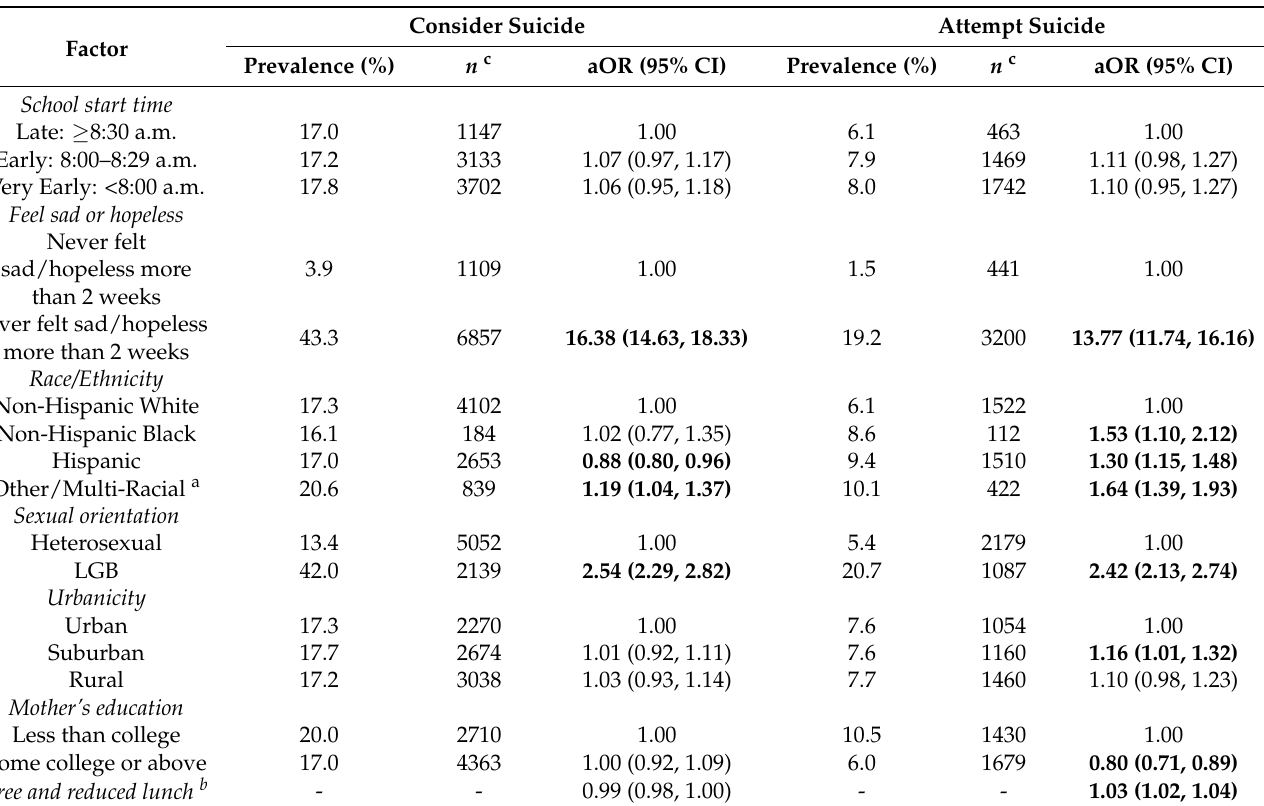
Table 3. Association between suicide-related behaviors and school start time, adjusting for mental health and demo- graphic